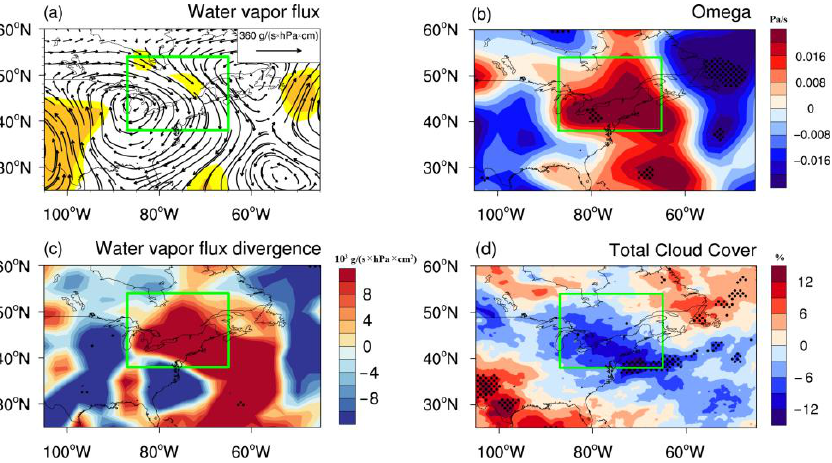
Figure 6. ( a ) Composite differences in April vertically integrated water vapor flux (vectors, g/(s × hPa × cm)) over 1000 – 600 hPa between positive and negative ASO anomaly events. Light and dark yellow areas represent values that are statistically significant at the 90% and 95% confidence levels, respectively. ( b – d ) Same as ( a ), but for vertical velocity at 700 hPa (Pa/s, Red (blue) colors represent descending (ascending) motion), water vapor flux divergence (units: 10 3 g/(s × hPa × cm 2 )), and total cloud cover (%), respectively. Detailed anomalous events can be found in Table 1. Black dots denote regions with correlation significant at the 95% confidence level.